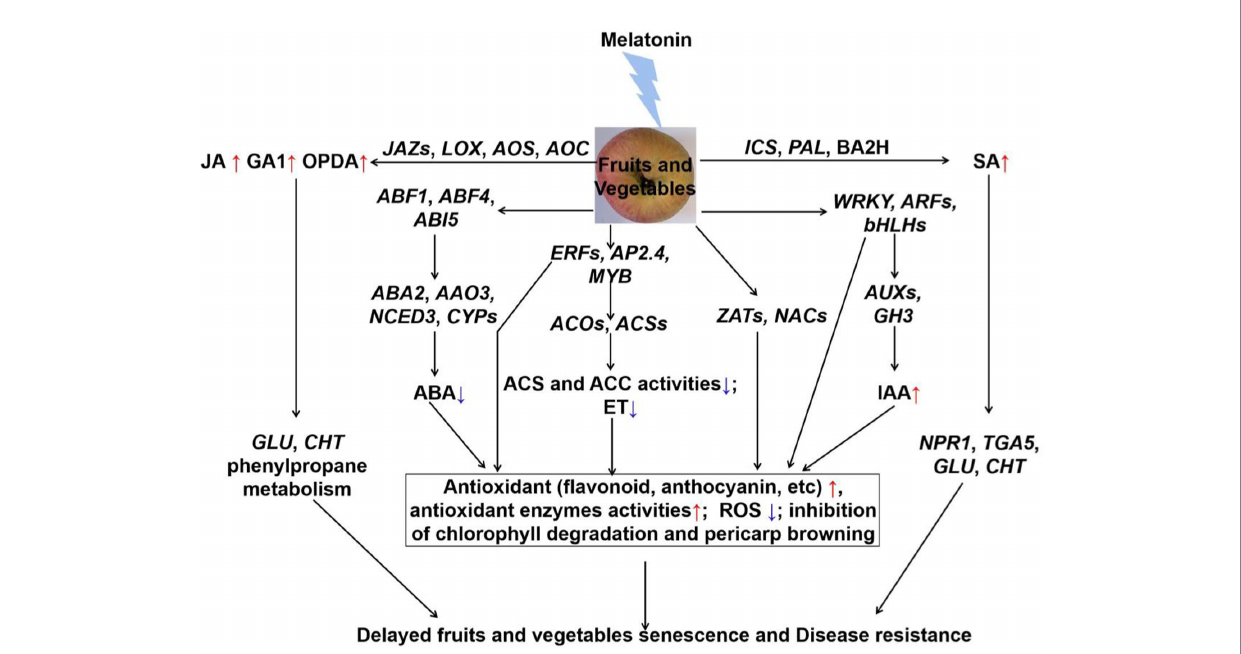
FIGURE 1 The crosstalk between melatonin and hormones of fruits and vegetables during the postharvest period. Exogenous application of melatonin reduced the ABA and ET content, and increased IAA content through regulating the related transcription factors and synthetic genes. Then, the significant antioxidants and antioxidant enzymes activities were induced to reduce the ROS accumulation, and chlorophyll degradation and pericarp browning were also inhibited. Besides, exogenous application of melatonin induced the JA and SA signaling pathways, and activated the proteins in the defense system to enhance the disease resistance in fruits and vegetables during storage. Jasmonic acid (JA), gibberellin 1 (GA1), 12-oxo-phytodienoic acid (OPDA), jasmonate ZIM-domain (JAZ), phenylalanine ammonia lyase (PAL), benzoic acid 2-hydroxylase (BA2H), lipoxygenase (LOX), allene